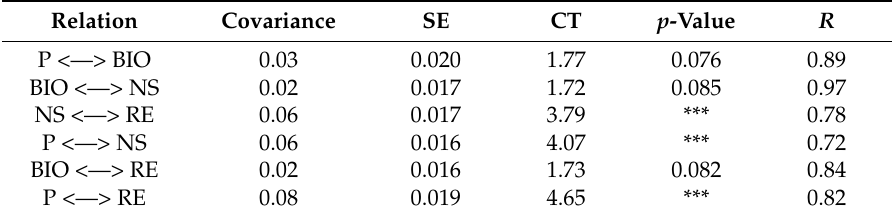
Table 4. Covariances and